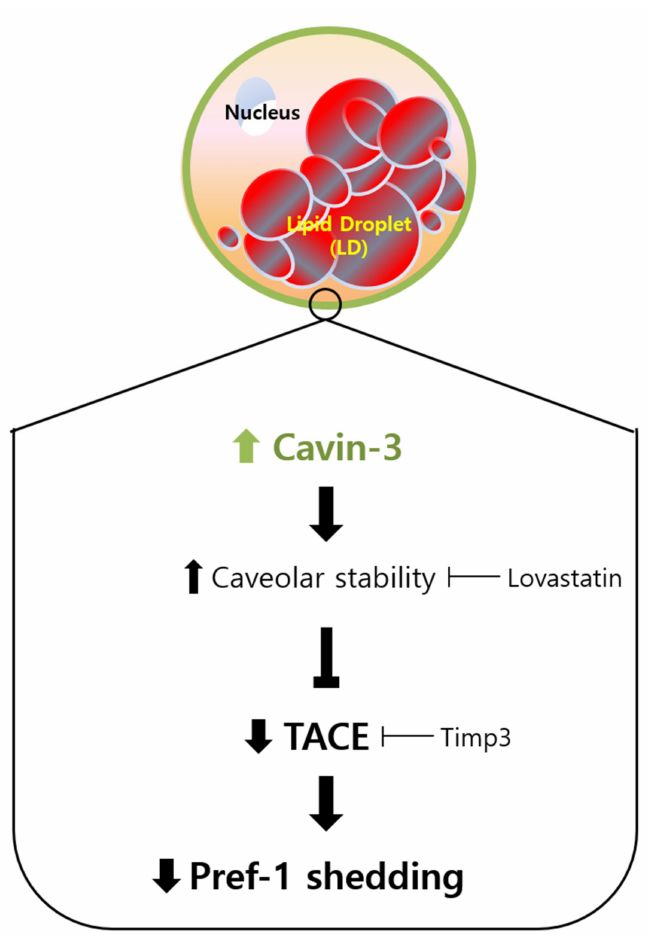
Figure 6. Schematic representation of the proposed mechanism for Cavin-3-mediated adipogenesis. Increased expression of Cavin-3 during the maturation of adipocytes induces caveolar stability, which in turn suppresses TACE activity involved in the Pref-1 shedding process, leading to the adipocyte di ff